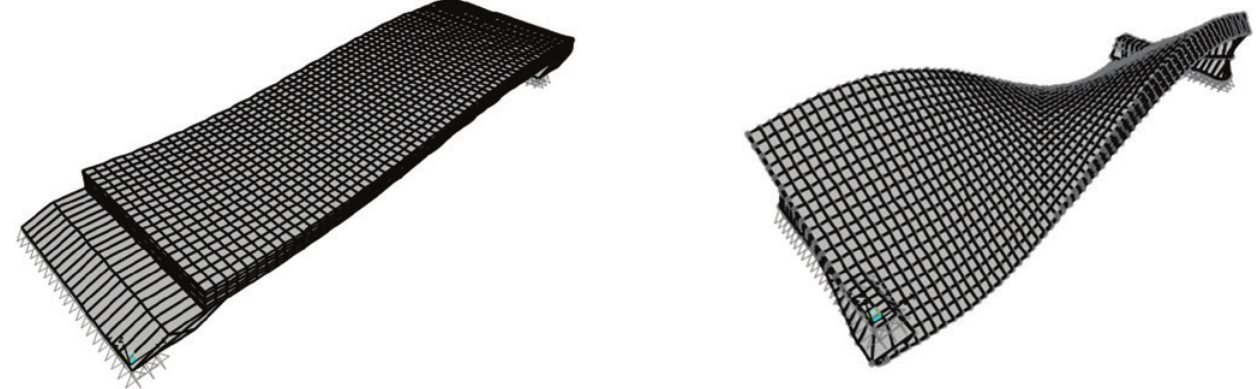
Modes of vibration and modal mass participation of the intact numerical model